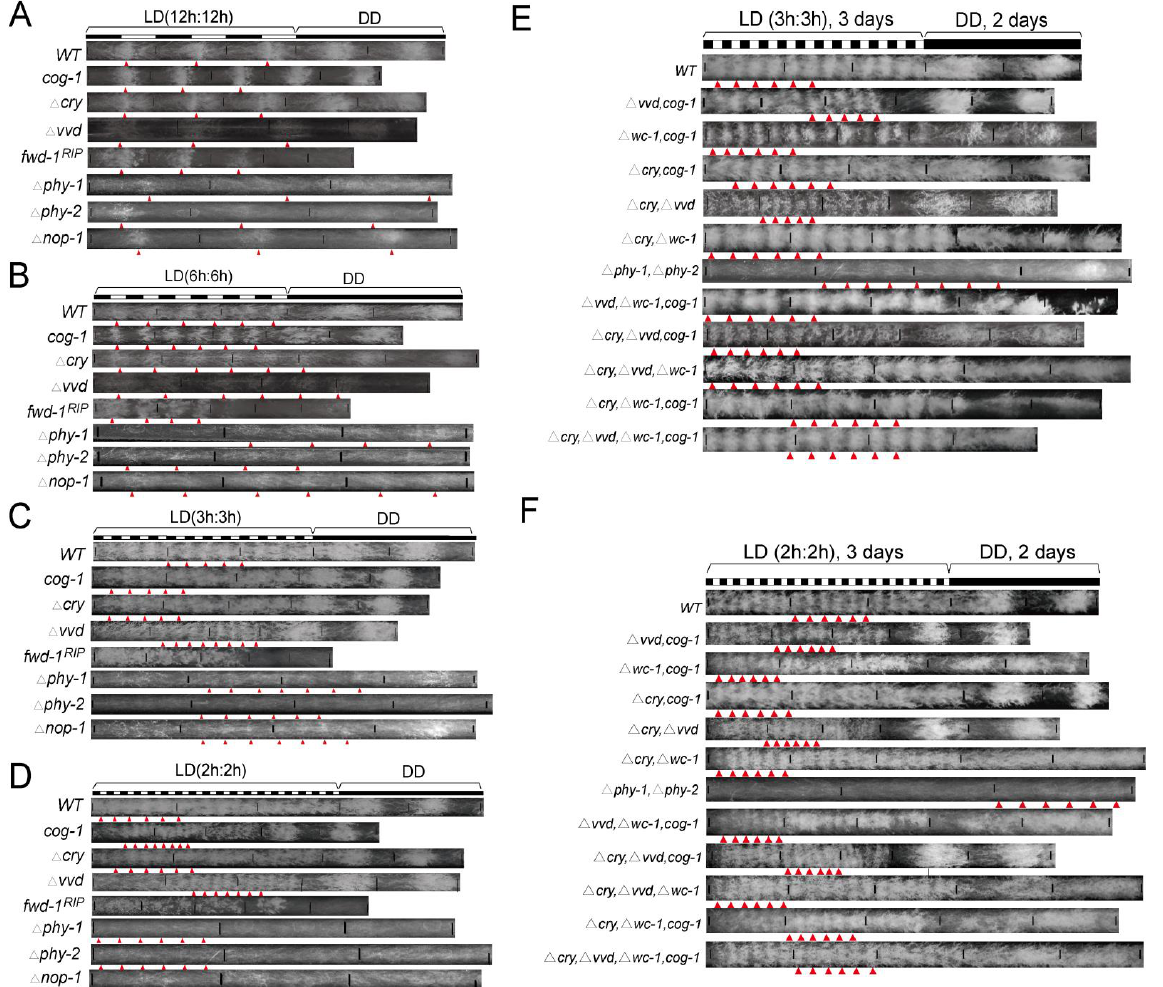
Figure 4. Impact of light sensors on the adaptation to short LD cycles. Race tube results of indicated strains under indicated LD cycles ( A – F ). Represent results ( n ≥ 3) are shown. Triangles denote the conidiation bands. The strains were grown under white light and the light intensity was 5000